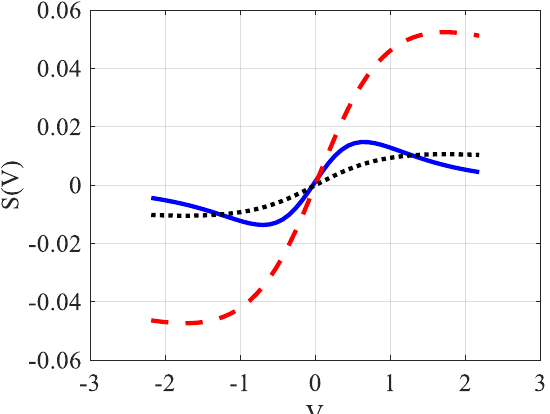
Figure 5. (color online): Comparison of the signal given by the simulation without approximations (solid blue line) with that from Equation (6) (dashed red line) used to characterize the TL effect. The dotted (black) line is the fitting of the solid blue line representing the exact signal.